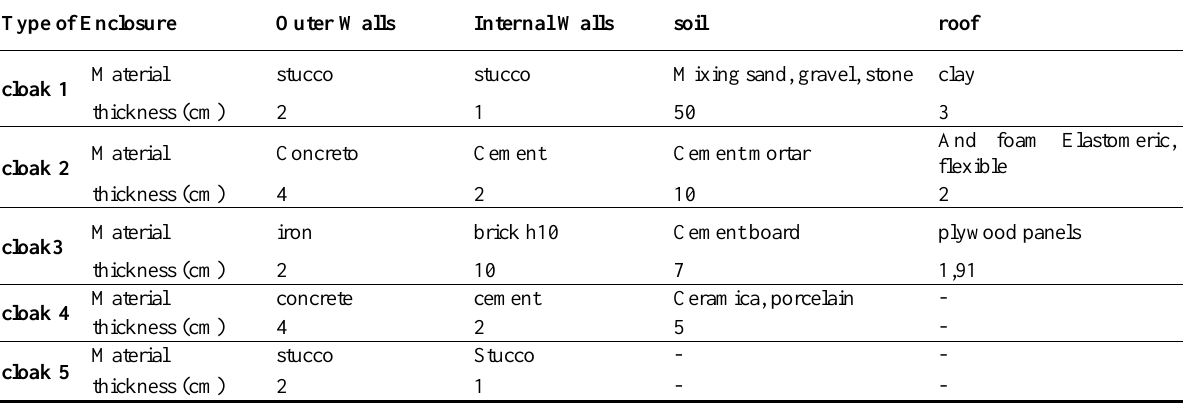
Table 1. Identification of the materials that make up the structure and evolvents of the architecture